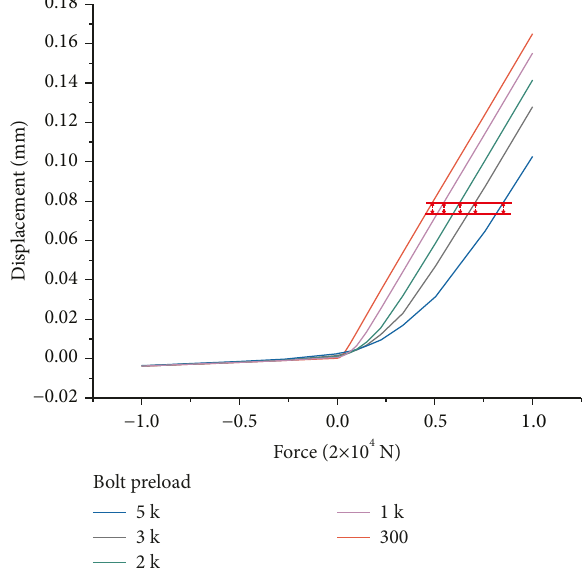
Figure 2: Force-displacement curves with different preload force.